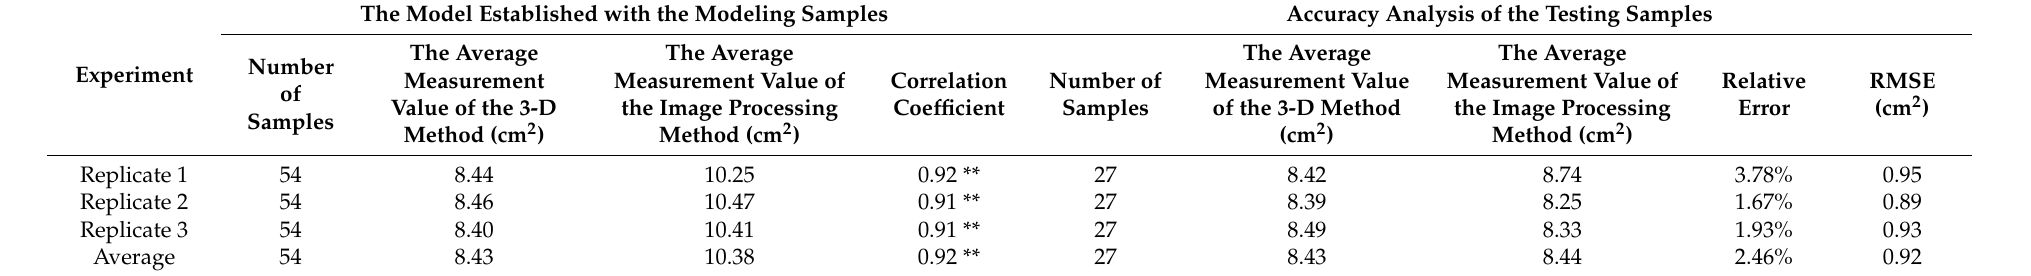
Table 1. Analysis of the accuracy of results measured by the image processing method.